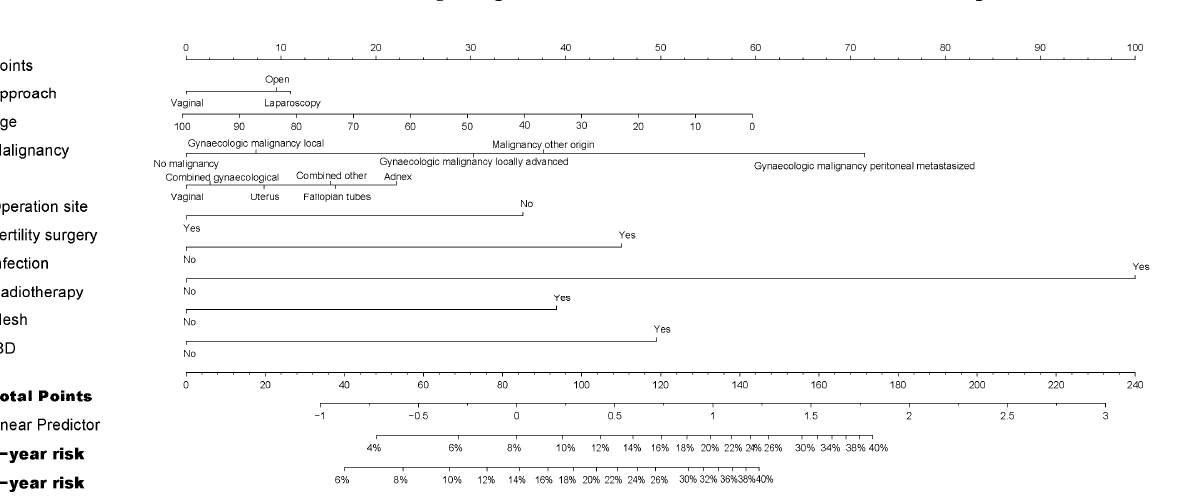
Figure 3. Nomogram to predict readmission possibly related to adhesions in women who underwent gynecological surgery. IBD = inflammatory bowel disease.